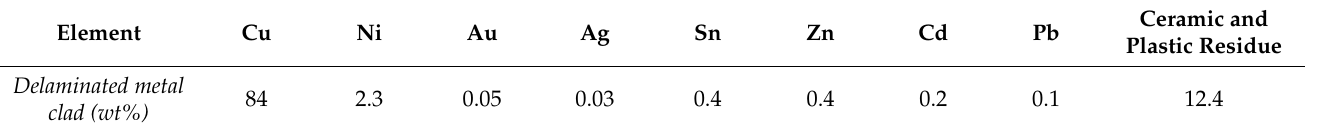
Table 1. Elemental composition of WPCB metal clad with plastic residue.